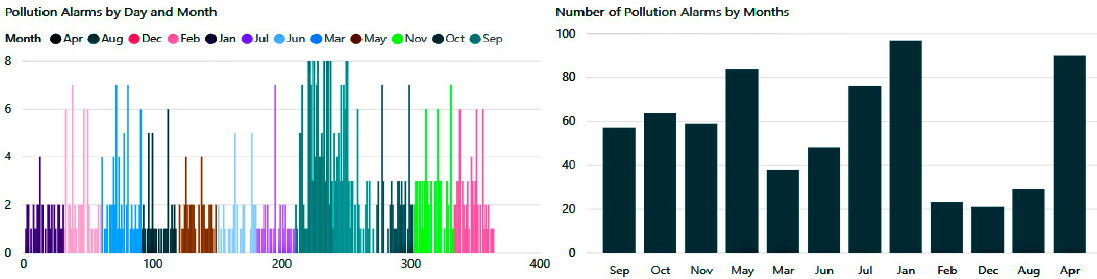
Figure 22. Number of alarms when the pollution index is dangerous.